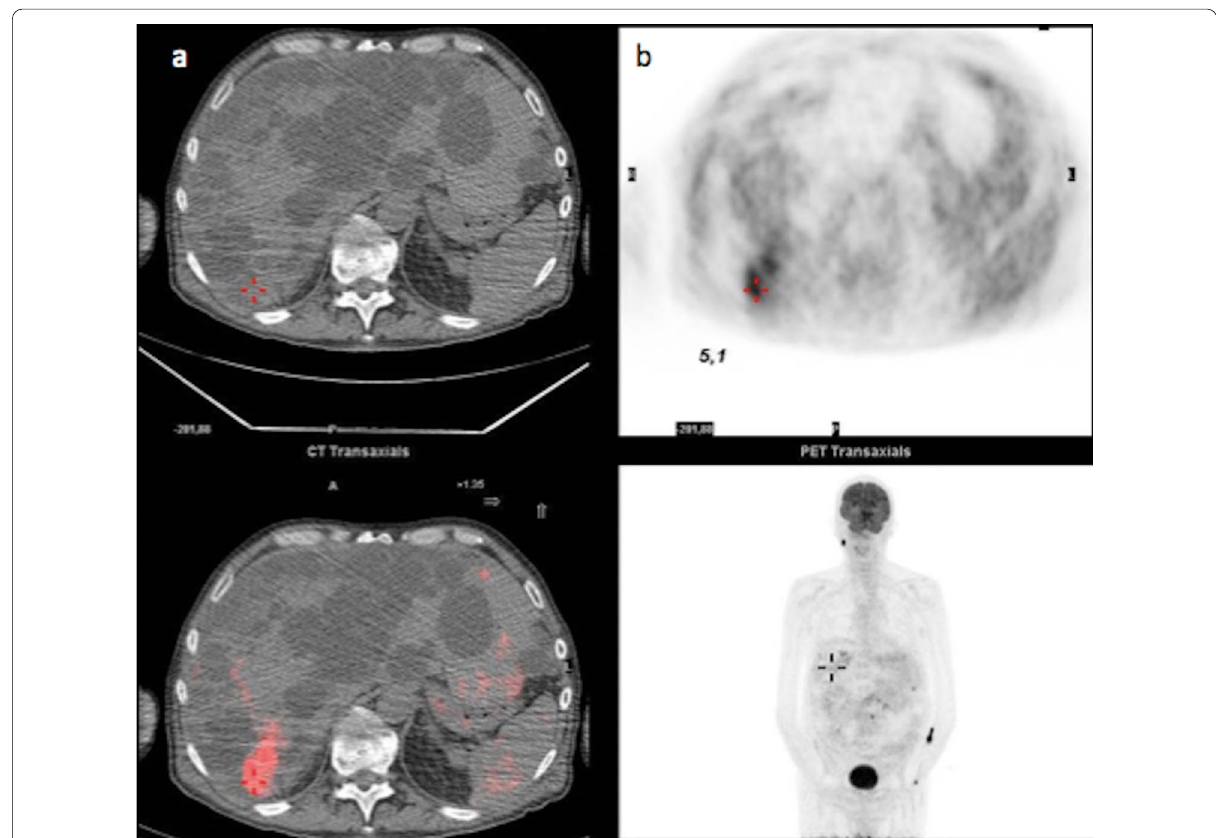
Fig. 14 Infected cyst in a 65-year-old male patient with autosomal dominant polycystic liver disease. a Axial non-enhanced computed tomography depicts one more attenuating cyst among multiple simple cysts (cross); b 18-F-FDG PET imaging shows the increased metabolism of that cyst (SUV at 5,1)